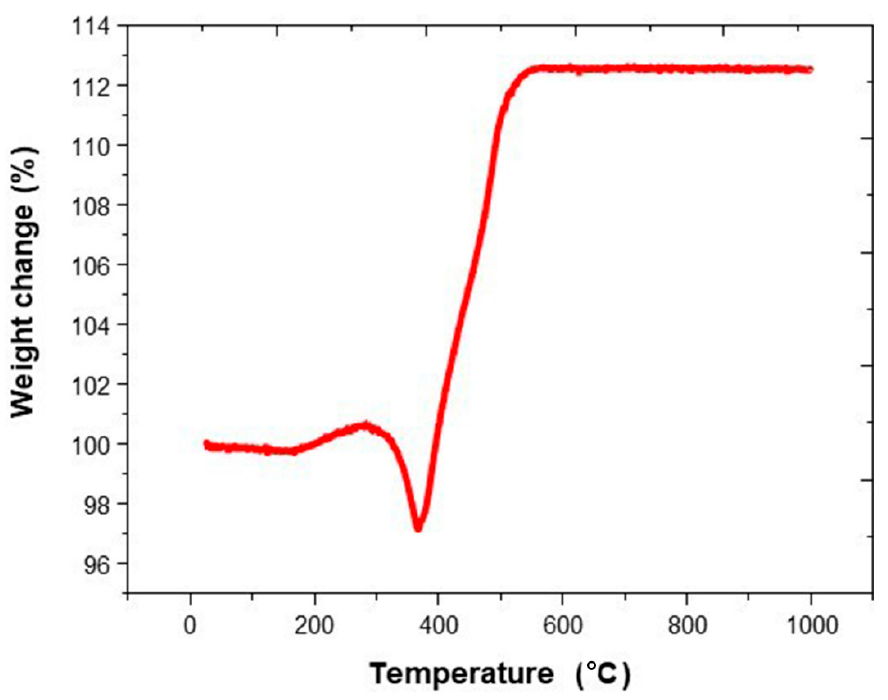
Figure 2. Thermogravimetric analysis of the as-synthesized Cu hollow fibers. A heating rate of 1 ◦ C min − 1 was applied, in an atmosphere of air. A value <100% indicates a weight loss as compared to the weight of the as-prepared fiber, and a value >100% indicates a weight gain.